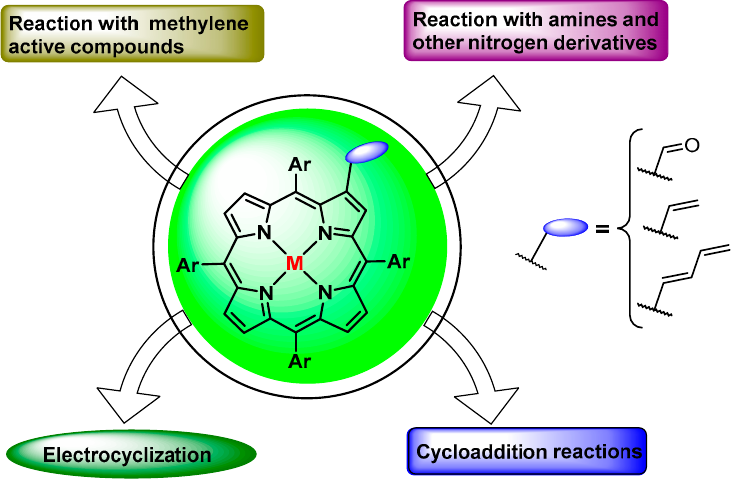
Figure 3. Types of reactions that are discussed in this review.